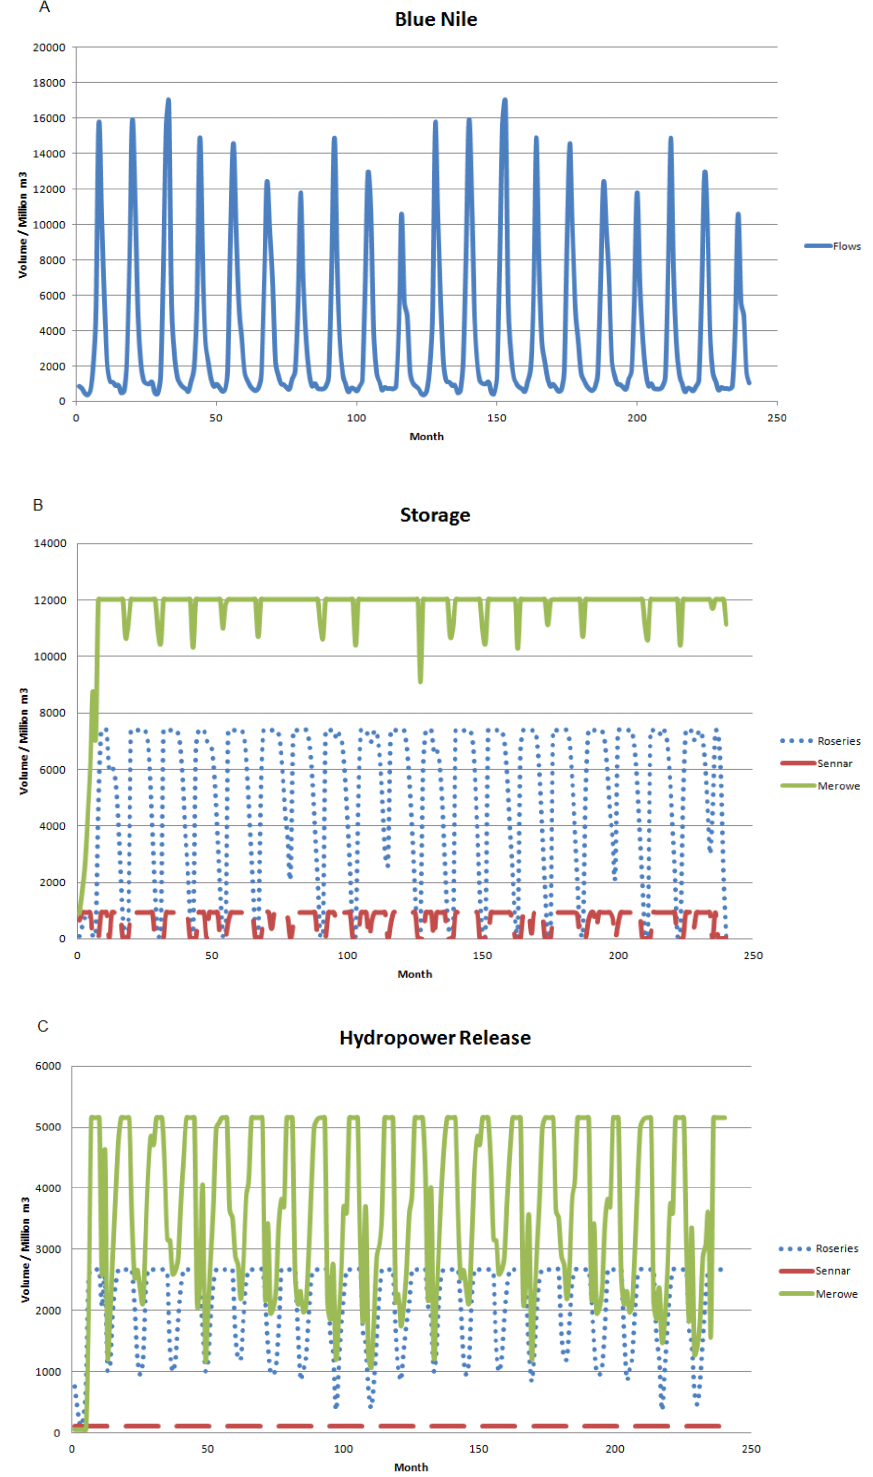
Figure 3. Annual cycle of (a) observed flow, (b) storage and (c) hydropower release at the three dams over the 20 year demonstration